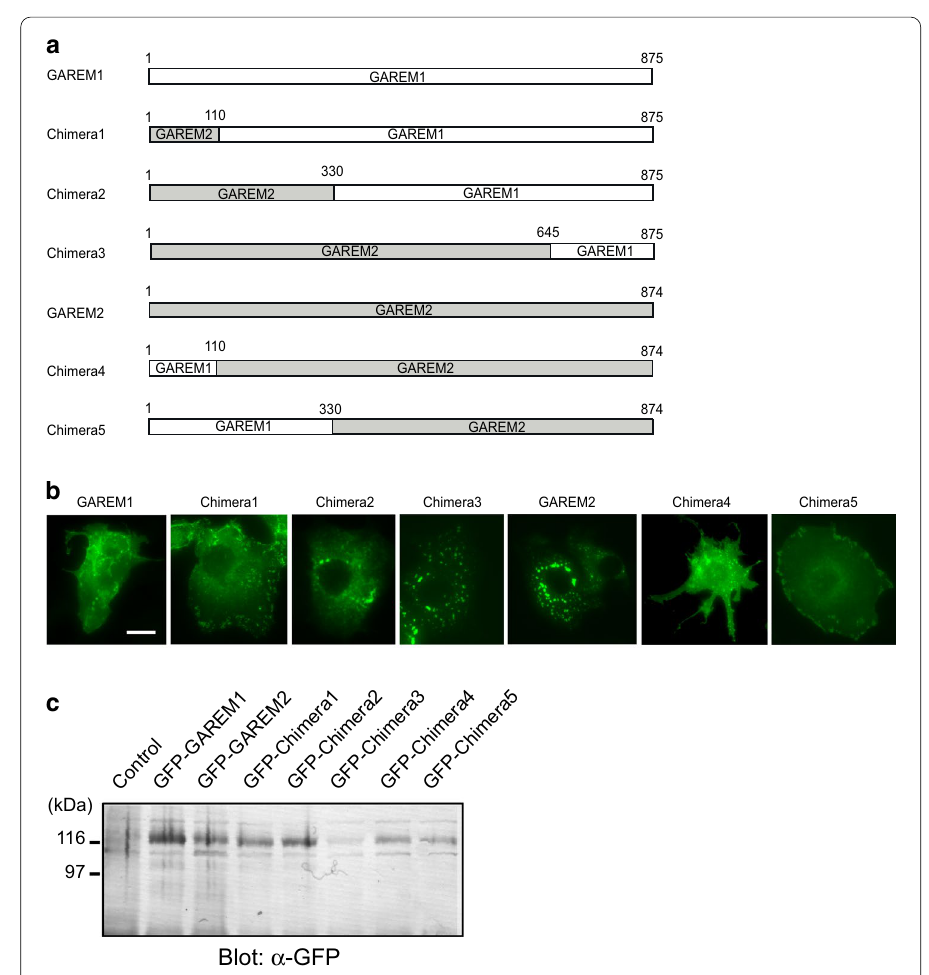
Fig. 2 Identification of a necessary region for forming GAREM2-specific dot-like aggregation by using chimera proteins of both GAREM1 and GAREM2. a Schematics of the GFP-fused full-length and chimera protein constructs of GAREM1 and GAREM2. The numbers indicate amino acid residues. b All recombinant proteins were expressed as the N-terminal GFP-fused form. Each construct was transfected into COS-7 cells, and then we analyzed their localization by GFP-fluorescence signal in the EGF-stimulated cells for 30 min. Representative results are shown. Scale bars 10 μm. c Confirmation of expressing chimera GAREM proteins = in COS-7 cells by immunoblotting using with GFP